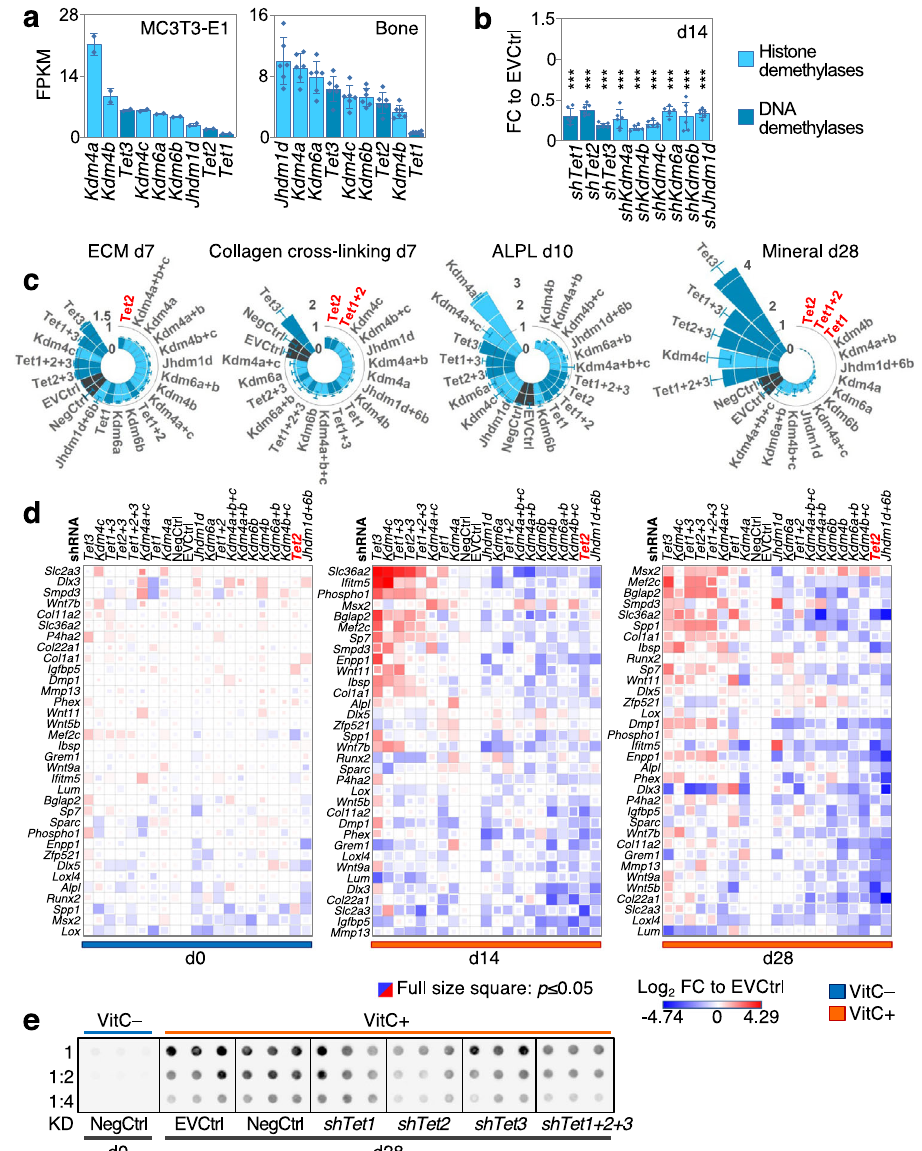
Fig.7|LossofHistonedemethylasesandDNAhydroxymethylases,particularly TET2, impairs osteogenic differentiation. a Gene expression of VitC-dependent epigenetic hydroxylases in MC3T3-E1 cells and mouse femur. b shRNA mediated hydroxylases knockdown ef fi ciencies in MC3T3-E1 cells. c Ranked relative extra- cellular matrix (ECM) deposition, collagen cross links measured via FTIR, alkaline phosphatase activity (ALPL) and ECM mineralization after suppression of hydro- xylases in MC3T3-E1. d Two-way ranked osteoblastic gene expressions after